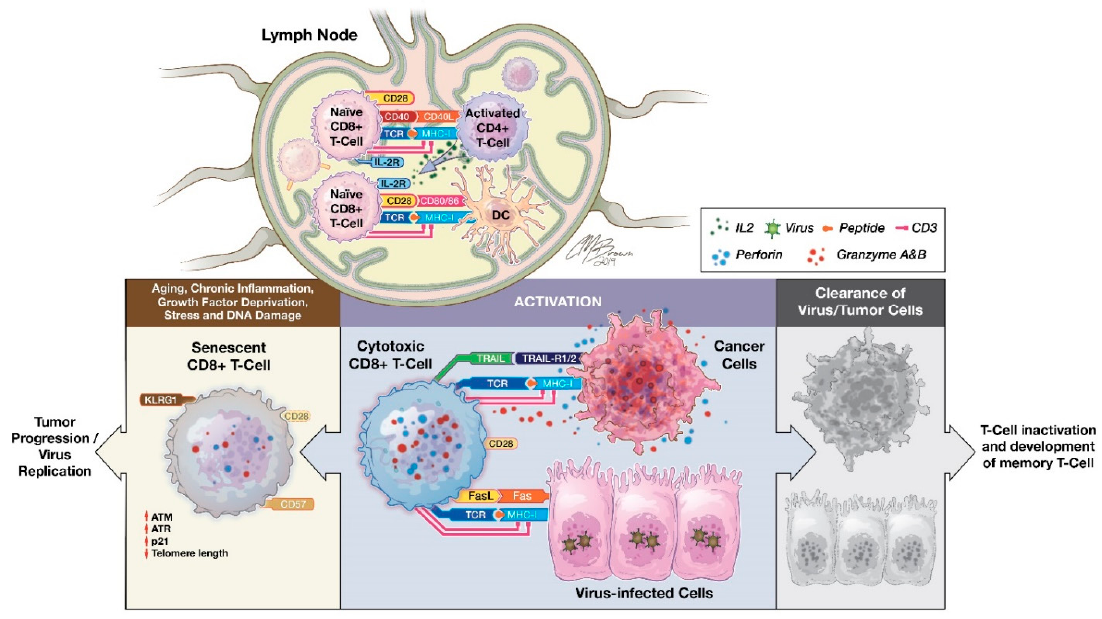
Figure 1. The priming and inactivation of CD8 + T cells. The interaction between TCRs and the peptide ‐ MHC complex is the first step toward antigen ‐ induced CD8 + T cell activation. This creates a site of extensive contact between T cells and APC, also called immunological synapses, where binding of CD28 on T cells with CD80/CD86 on APCs transduces a pivotal secondary costimulatory signal to complete the priming of naïve CD8 + T cells. In addition, CD4 + T helper (Th) cells